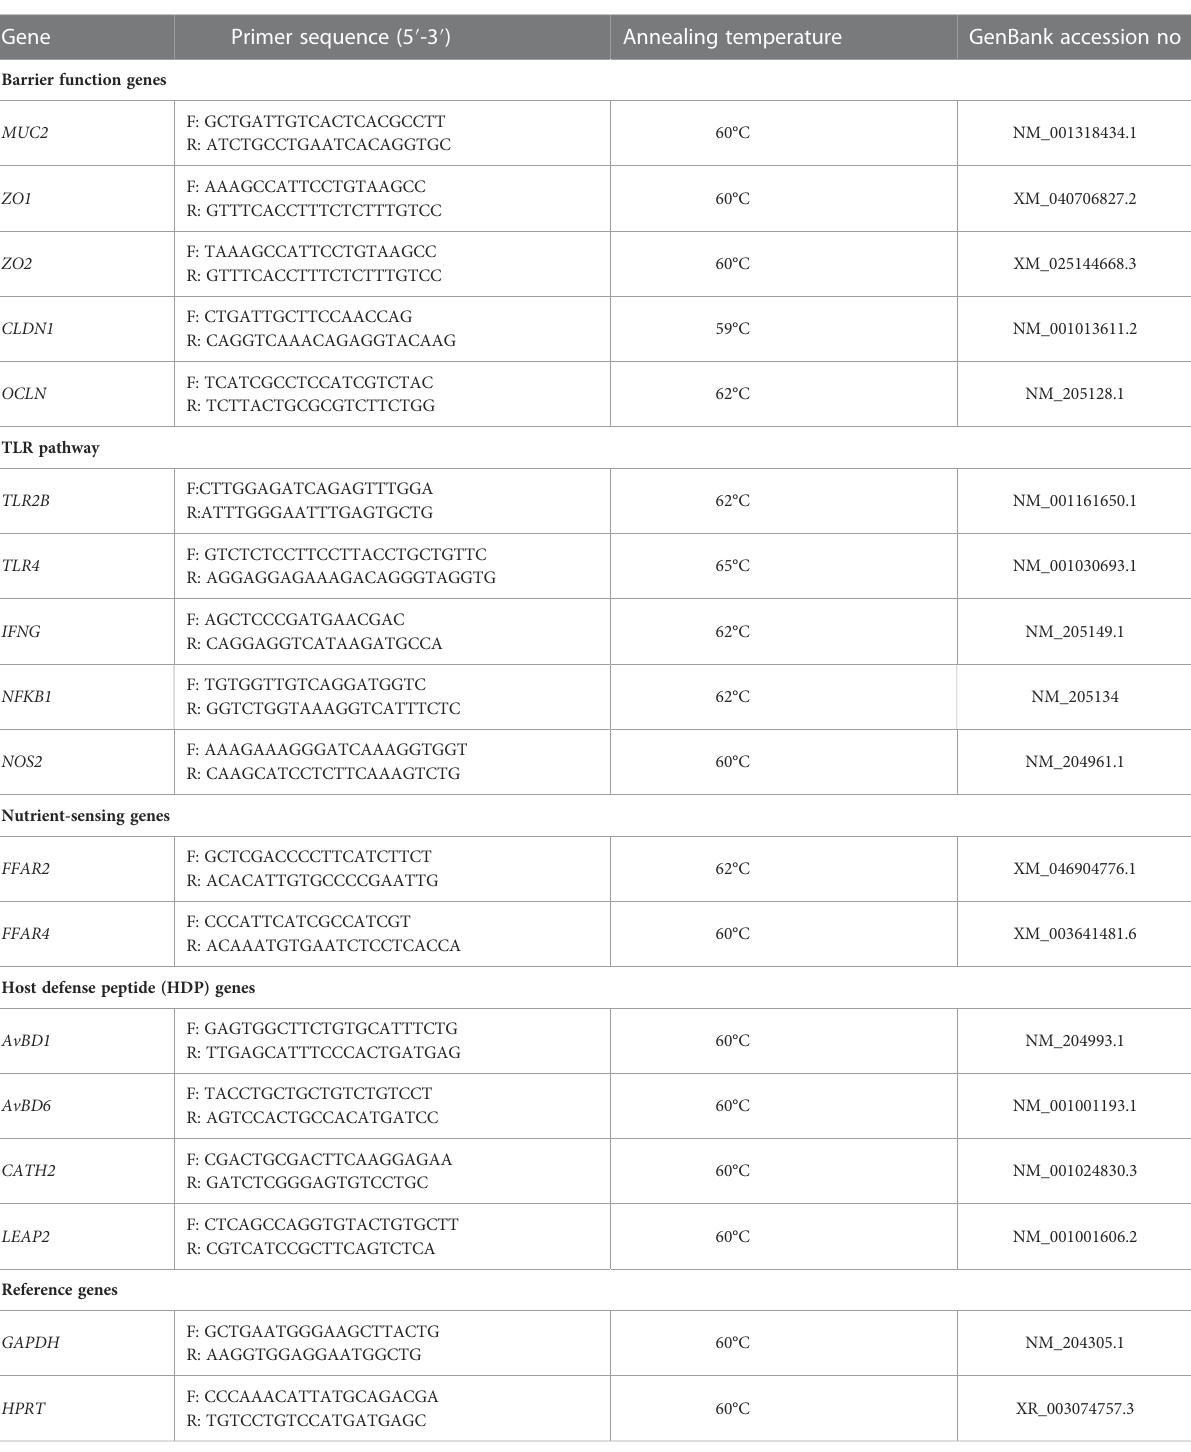
TABLE 3 Oligonucleotide primers used for quantitative RT-PCR.